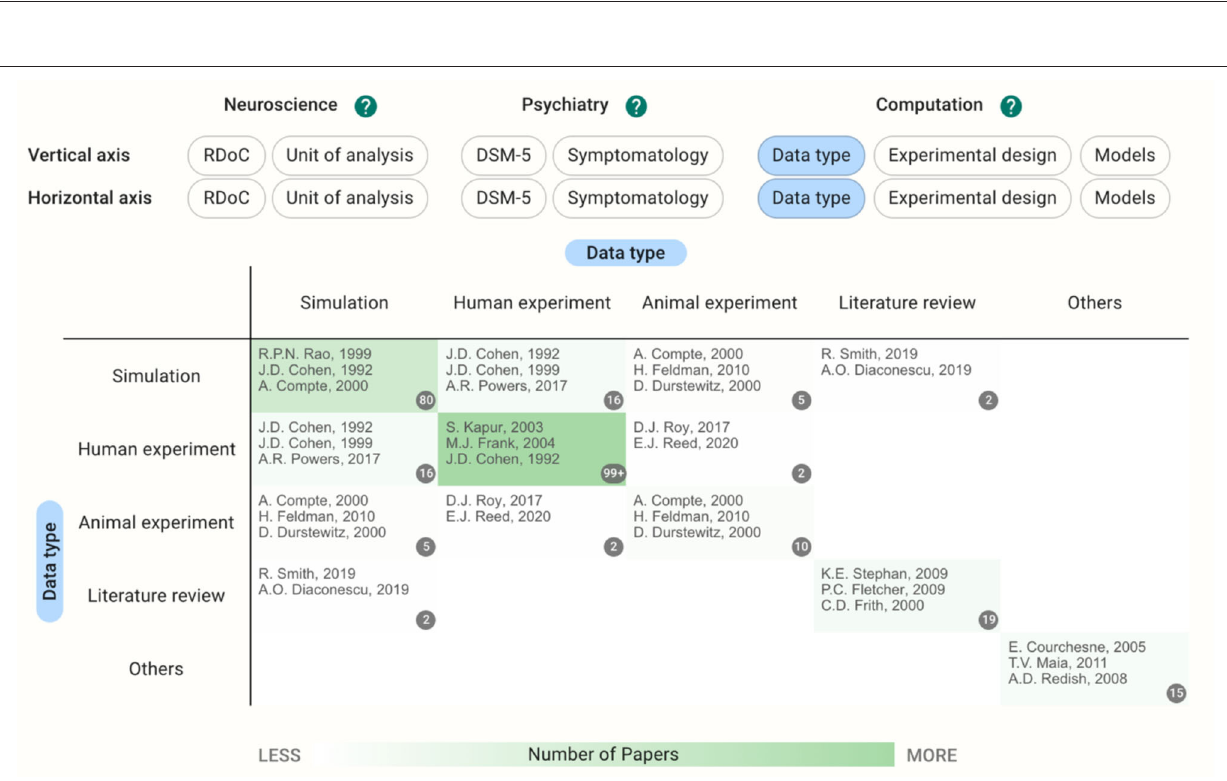
Frontiers in Psychiatry |